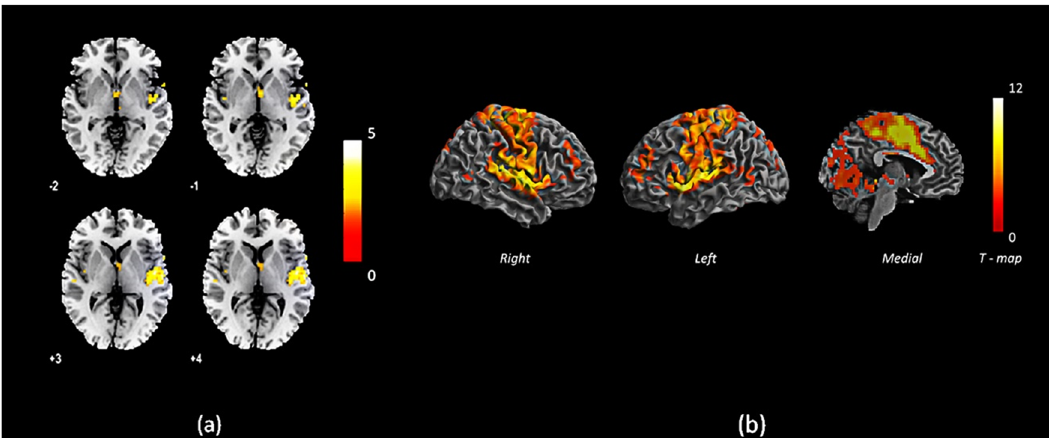
Fig. 1 Cluster with reduced centrality and its functional connectivity in FEP compared to healthy control subjects. a Brain regions showing reduced centrality in the FEP ( n = 38) group compared to HCs ( n = 31), b Functional connectivity of the STG/insula cluster to other brain areas for subjects in the FEP group ( n = 38). The colour bars indicate T -values. Table 3. Functional connectivity of the STG/insula cluster to other brain areas for subjects in the FEP group ( n = 38). Brain regions included in cluster (AAL